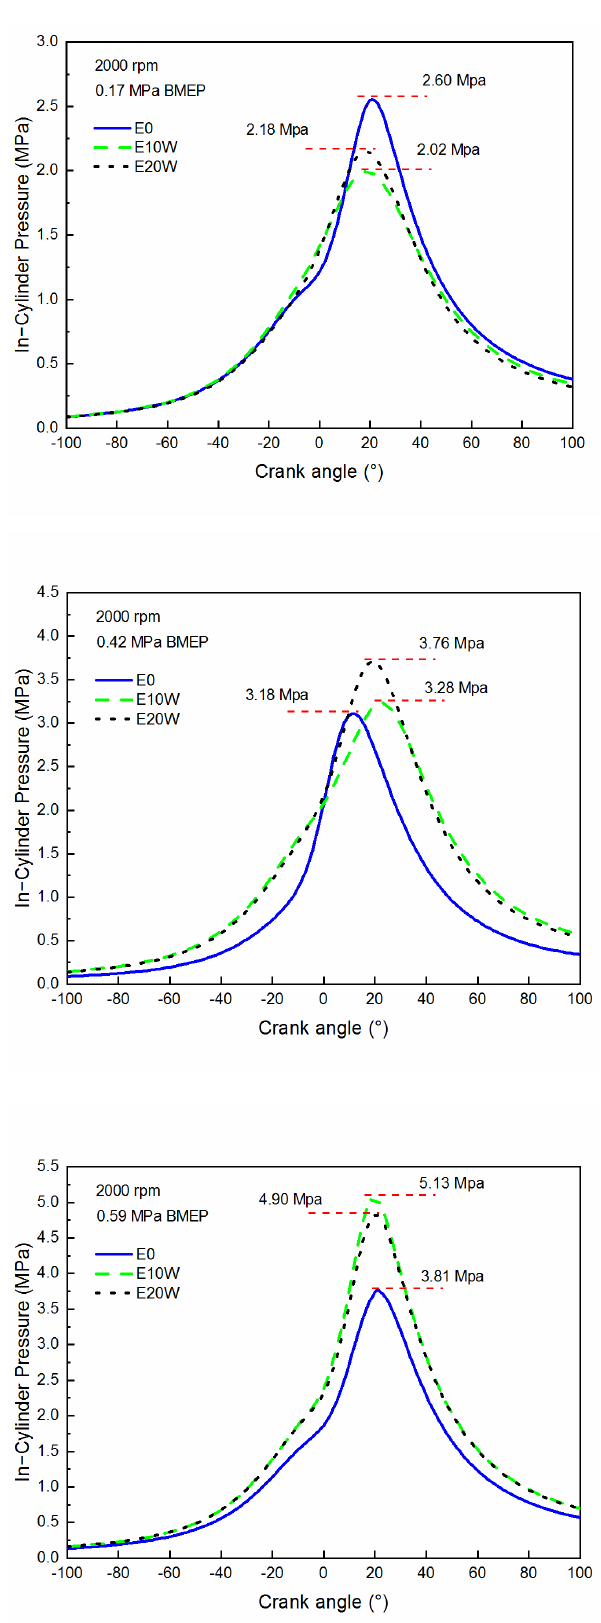
Figure 4. The average in-cylinder pressure of E0, E10W and E20W for three various loads.